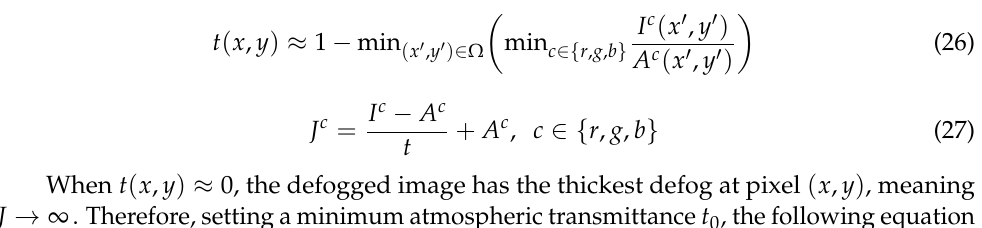
Figure 12. Schematic diagram of target area extraction and defogging of the area.